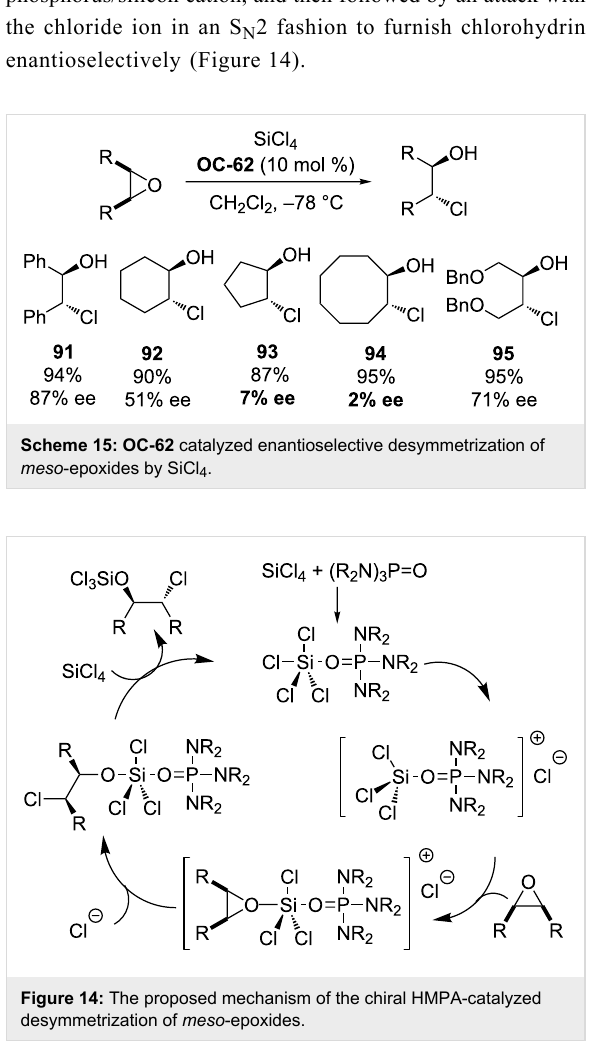
From this description, the activation of SiCl 4 was depending on the formation of the chiral complexation of the phosphorus/ silicon cation through the oxygen atom of P=O and the coordi- nation with the silicon atom of the nucleophiles. It can be deduced that the chiral phosphine oxides can also play a role